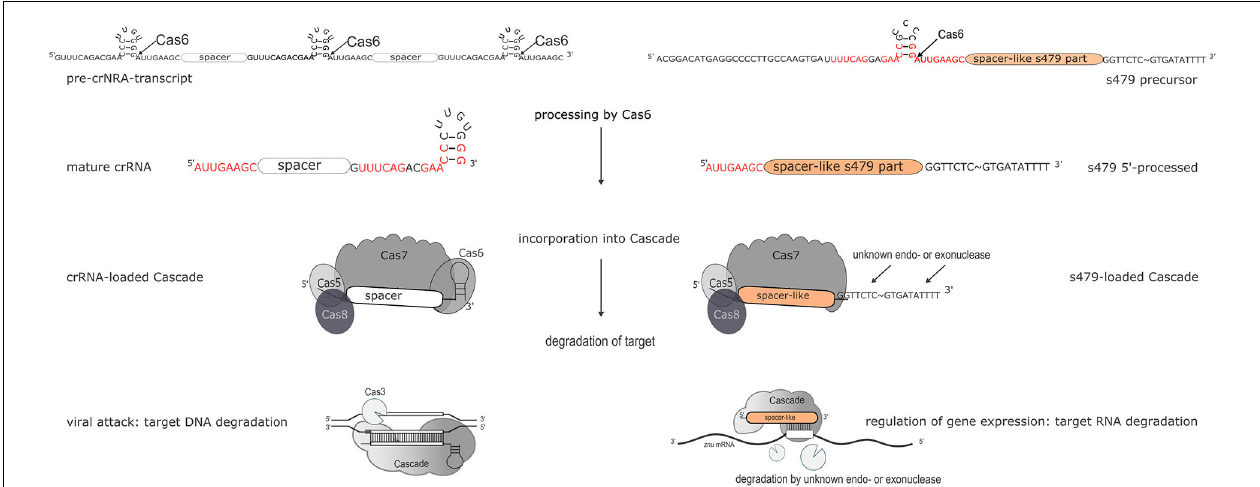
FIGURE 11 | Maturation and function of crRNAs and s479. CRISPR arrays are transcribed into long precursors that are processed by Cas6 to yield the mature short crRNAs (left side). The mature crRNA is then loaded into the Cascade complex and guides Cascade to the invader to degrade the invader DNA. According to the data presented here, s479 is also transcribed into a precursor RNA and processed by Cas6. s479 seems to be bound by Cascade via the crRNA-like 5 (cid:48) handle and s479 might guide Cascade to the target znu C1 mRNA triggering its degradation.